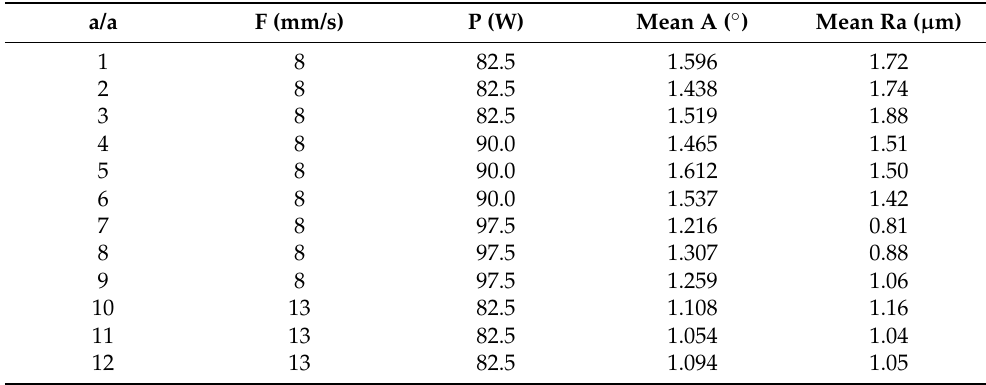
Table 2. Laser cu tt ing experiments and corresponding results for A and Ra responses. Table 2. Laser cutting experiments and corresponding results for A and Ra